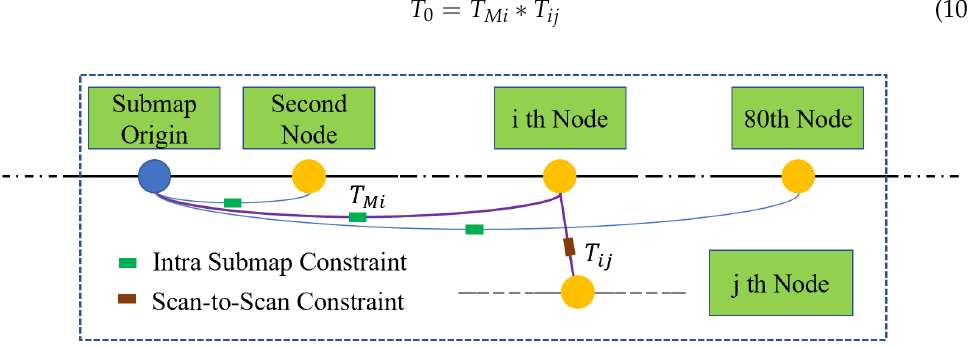
Figure 3. The process of solving node to submap constraints. When node j comes to a position not too far from node i , we find the transformation from node i to node j using ICP brute force